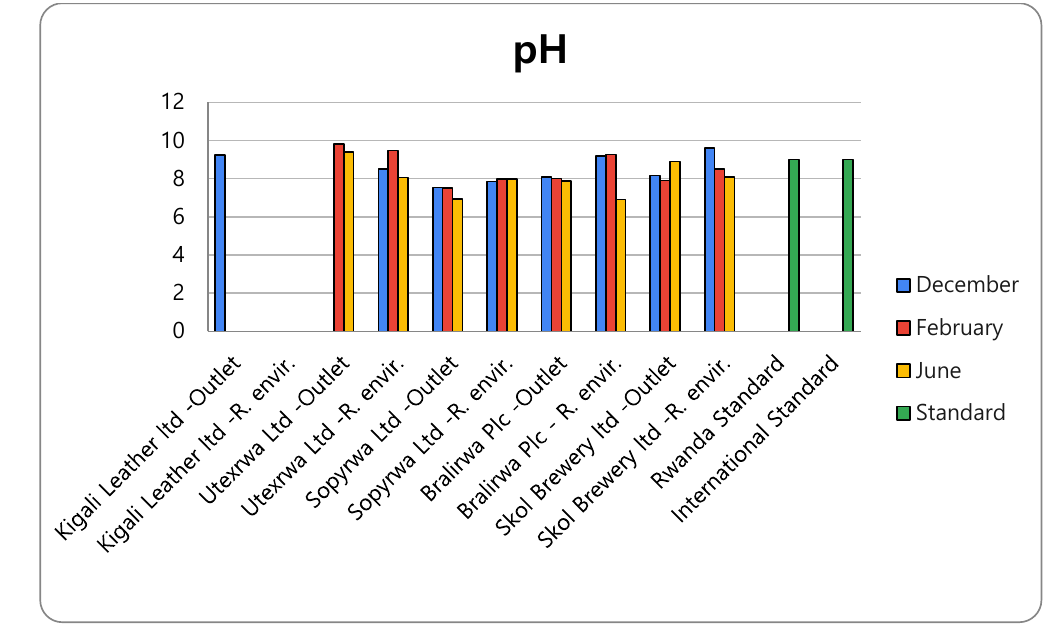
Figure 2. pH levels per site. Table 3. BOD 5 results for the selected industries. BOD 5 (mg/L)